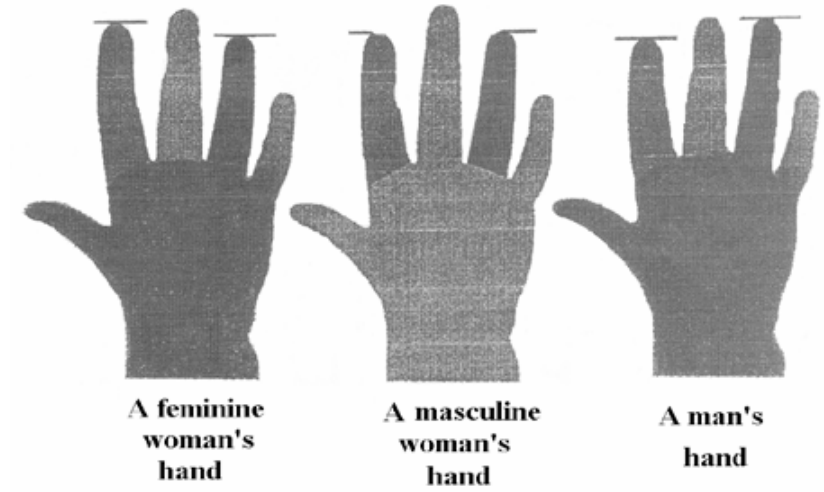
Figure 2 . Finger proportions (2D: 4D) for women and